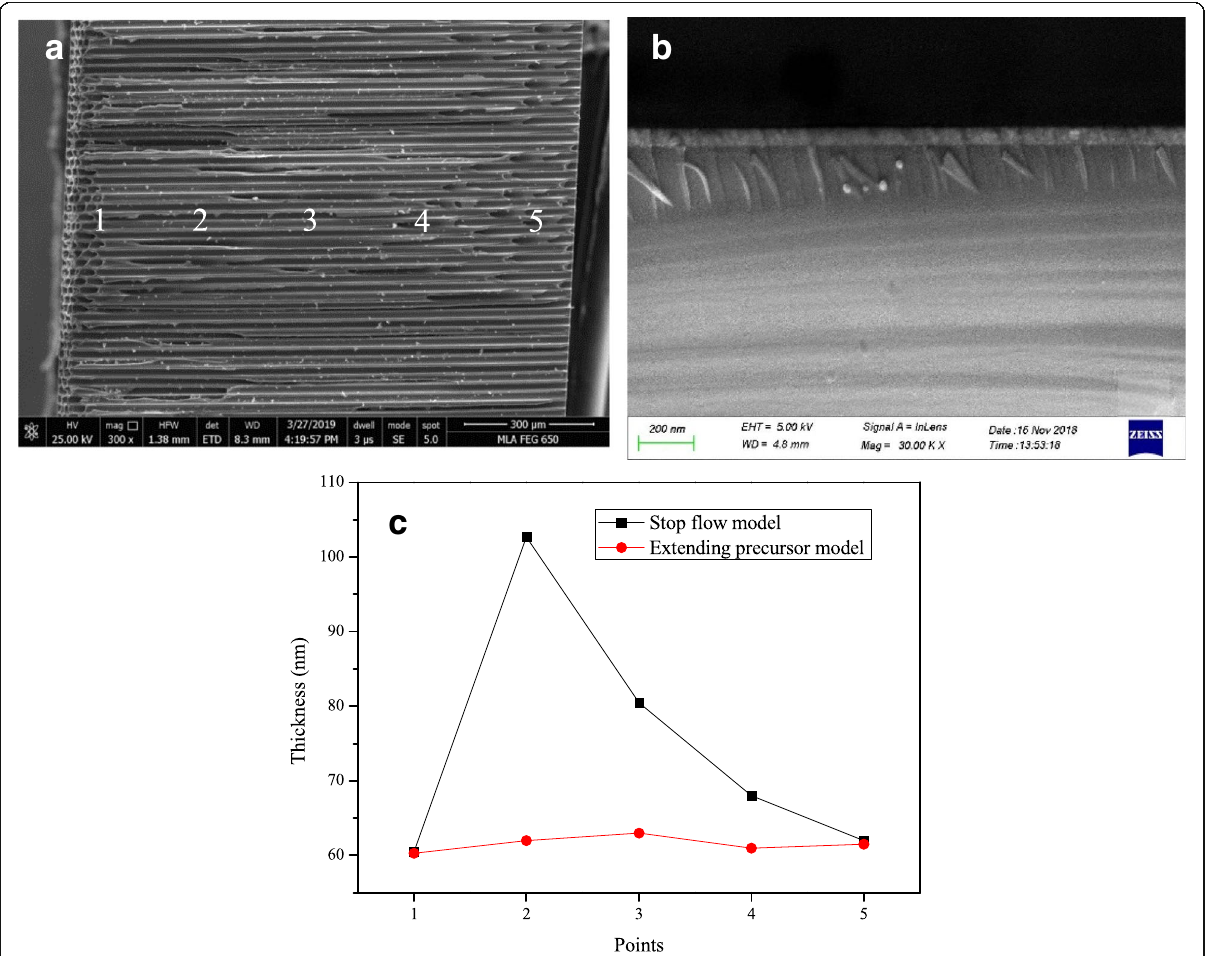
Fig. 6 Cross-sectional SEM pictures of MCP. a Cross-sectional SEM pictures of ALD-MCP samples. b Cross-sectional SEM pictures of Al2O3 layer on the surface of inner channel. c Thickness of SEE layer at different location measured with